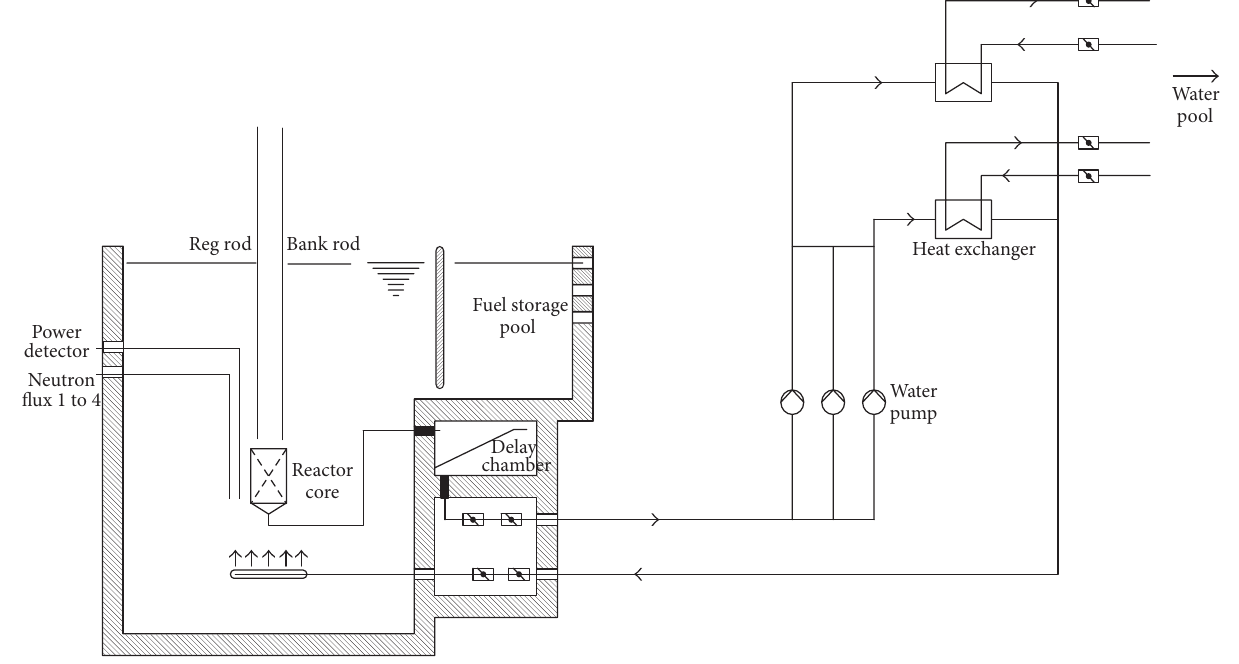
Figure 1: Coolant flow and position sensors in RSG-GAS [15].